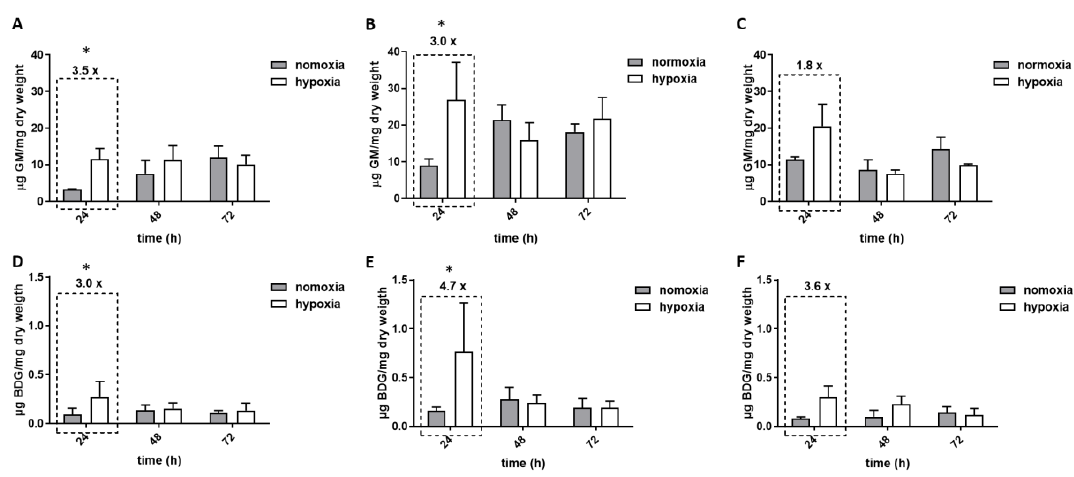
Figure 1. Galactomannan (GM) and beta-glucan (BDG) content in supernatant of clinically relevant aspergilli. A. fumigatus ( A , D ), A terreus ( B , E ), and A. flavus ( C , F ) cultures were grown in hypoxic conditions (white bars) and normoxic conditions (grey bars). The amount of GM and BDG was normalized to biomass (dry weight). Numbers above boxes indicate fold change of biomarkers released in hypoxia in comparison to normoxia, error bars indicate standard deviation, asterisks (*) indicate statistical differences (multiple t -test) between normoxic and hypoxic values.